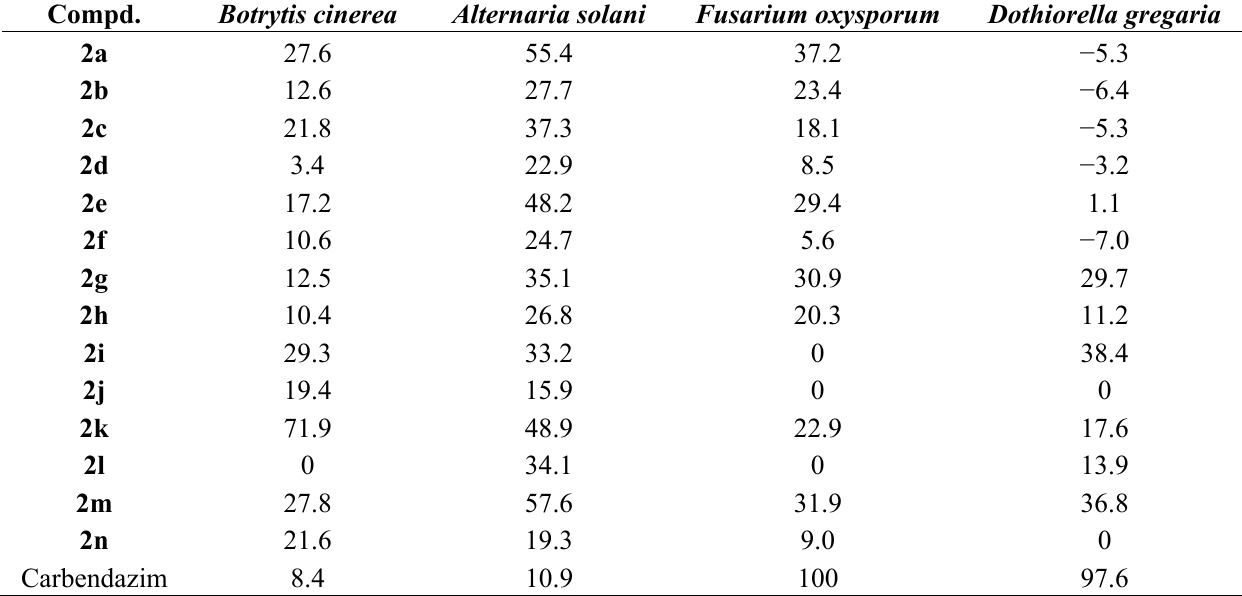
Table 4. The fungicidal activities (inhibition rate, %) of compounds 2 against several plant